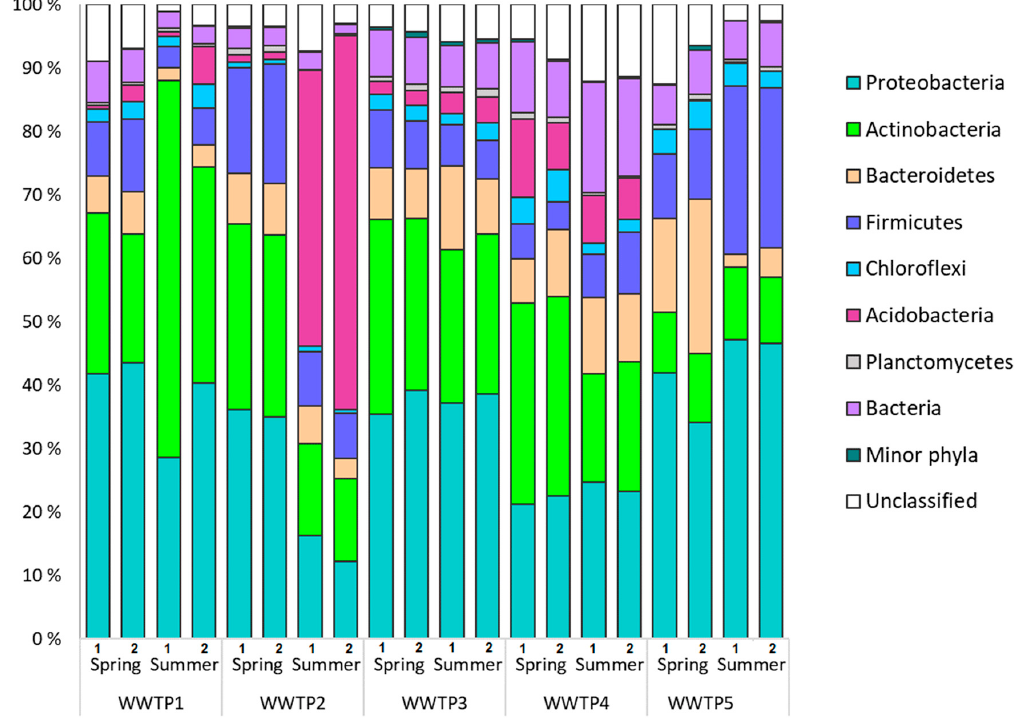
Figure 2. Relative abundance of bacterial phyla in Finnish wastewater treatment plants (WWTPs 1–5) during the spring and summer season.